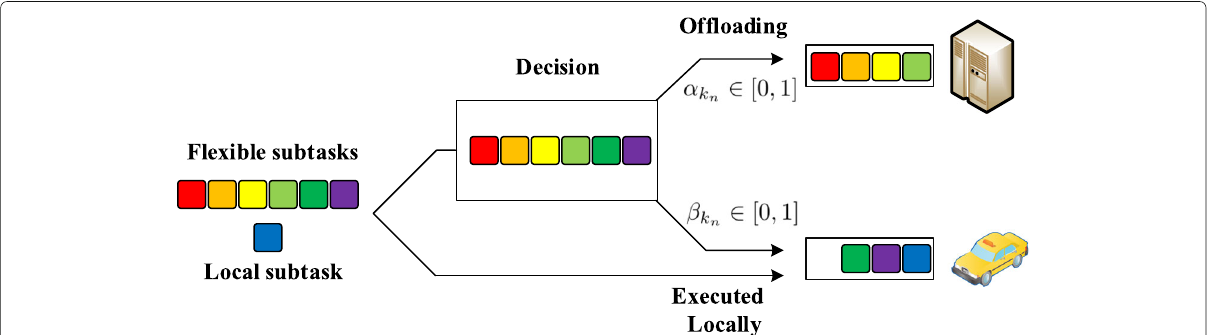
Fig. 2 Process of offloading and execution. The task generated by the vehicle are classified into two subtasks at t , the local subtasks should be executed locally, whereas the flexible subtasks could be executed locally or offloaded to the MEC server depending on the offloading decision